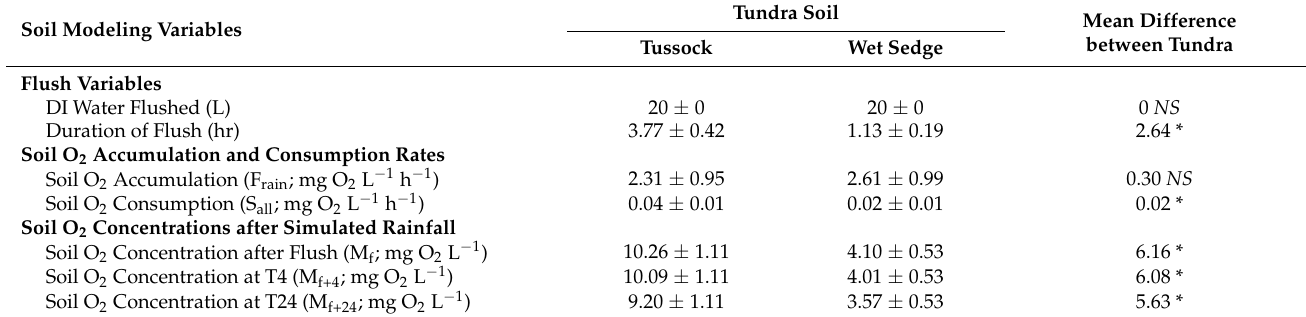
Table 2. Soil modeling flush variables, rates of soil O 2 accumulation, and concentrations of soil O 2 after simulated rainfall are for the biotic response cores. The soil O 2 consumption rates are modeled from soil properties reported for the abiotic response cores [5] and are representative rates within tussock tundra and wet sedge tundra soils under static, waterlogged field conditions. Asterisks indicate significant differences in mean pairwise similarity among tundra soils (paired t -test; * p < 0.05; NS = no statistically significant